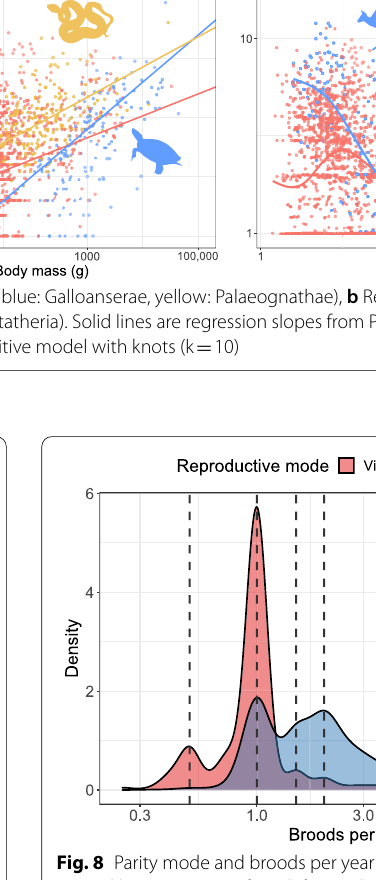
Fig. 7 Broods per year. Red: birds; blue: squamates; purple: turtles; yellow: placental mammals; brown: marsupial mammals. Dashed vertical lines represent 0.5, 1, 1.5 and 2 broods per year. The x axis is log 10 scaled